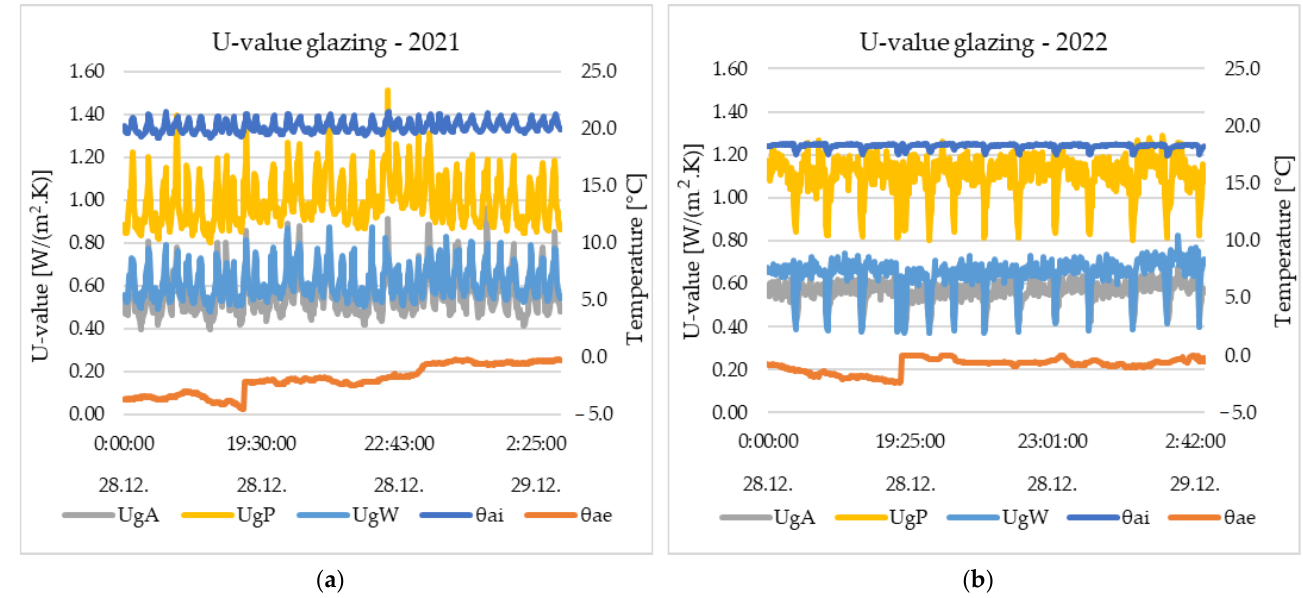
Figure 8. U-value glazing of all three window constructions on the selected date: ( a ) 2021; ( b ) 2022. From the measured data, the average glazing U-value and thermal conductance values were calculated and are summarized in Table 3. For comparison, the glazing U-value was also calculated based on normative standards. These values are shown in Table 4.